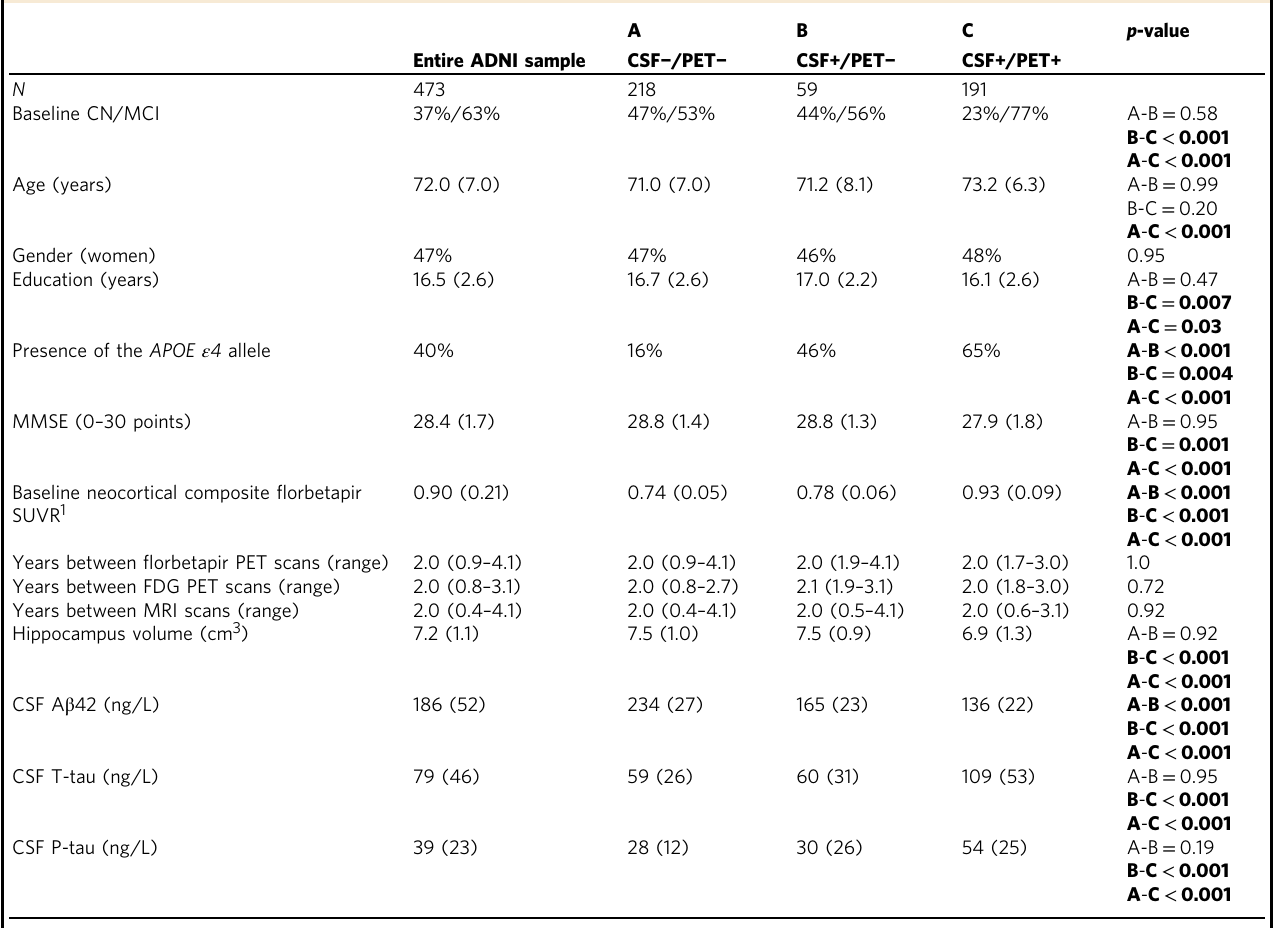
Table 1 Baseline characteristics of the ADNI